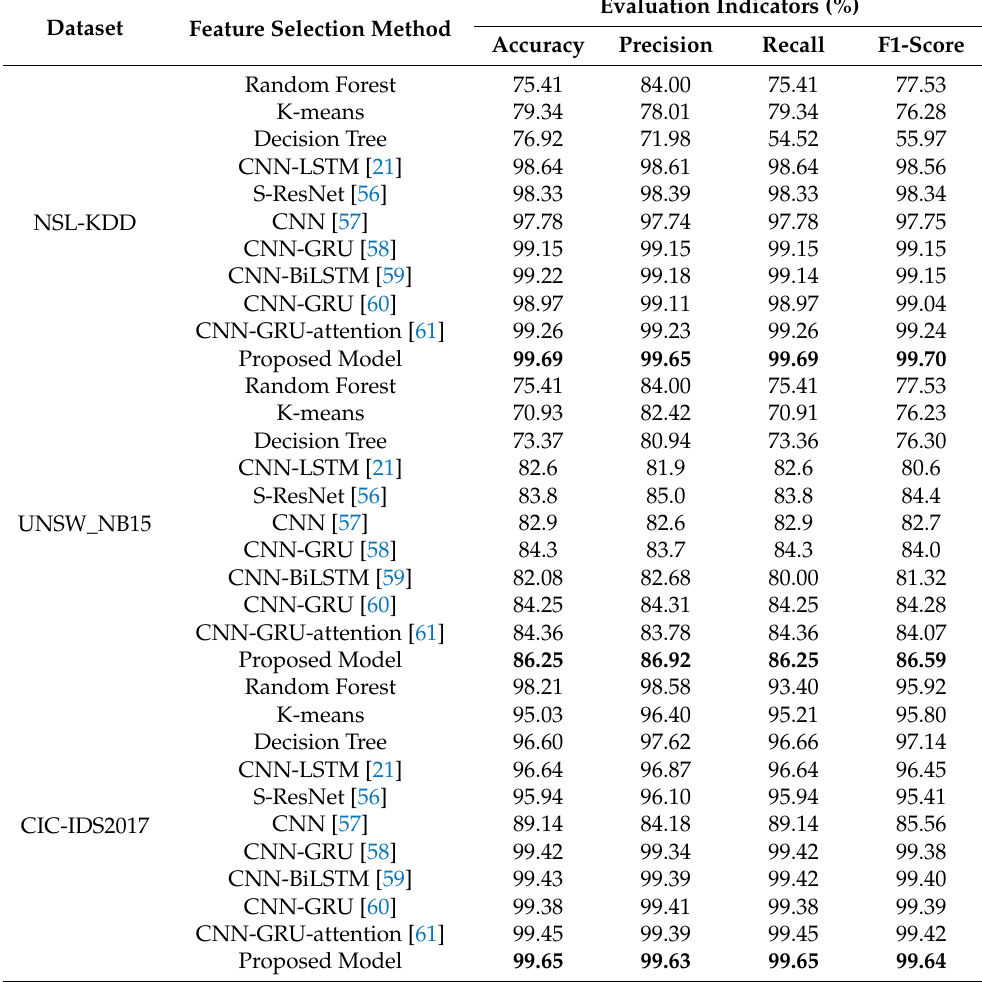
Table 13. Comparison of different